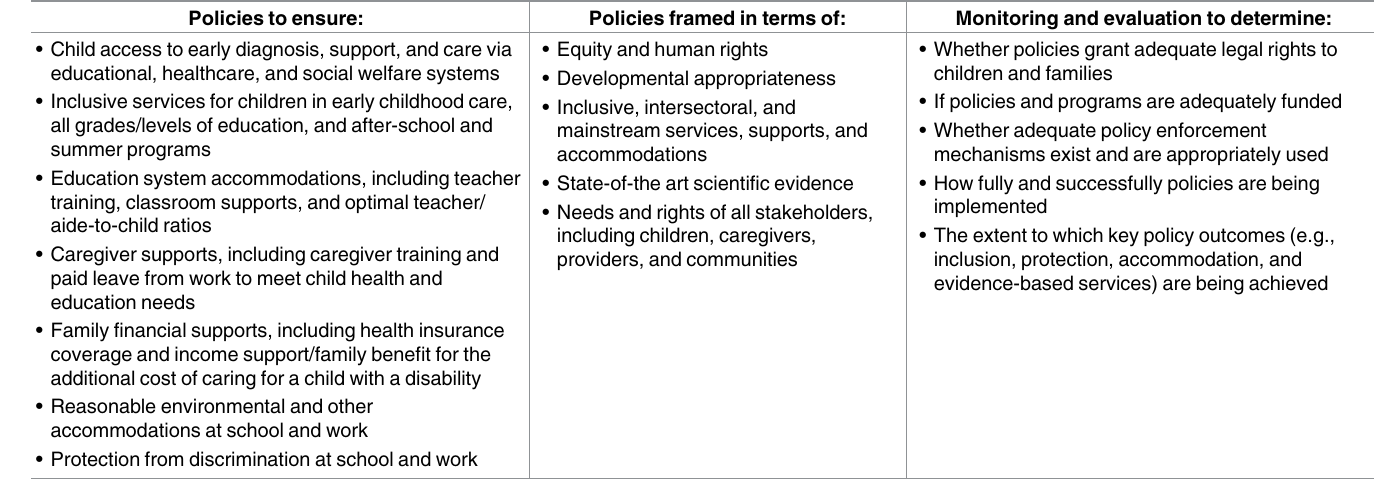
Table 2. Policies to support children with developmental delays and disabilities and their caregivers. Policies to